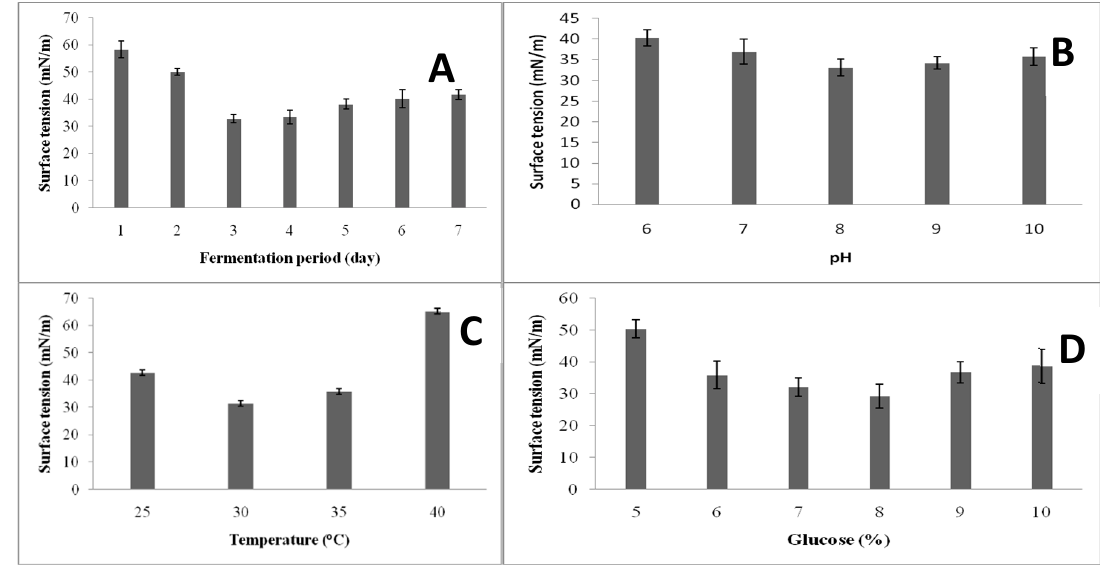
Figure 3. Effect of fermentation period ( A ), pH ( B ), temperature ( C ), and glucose concentration ( D ) on biosurfactant production.